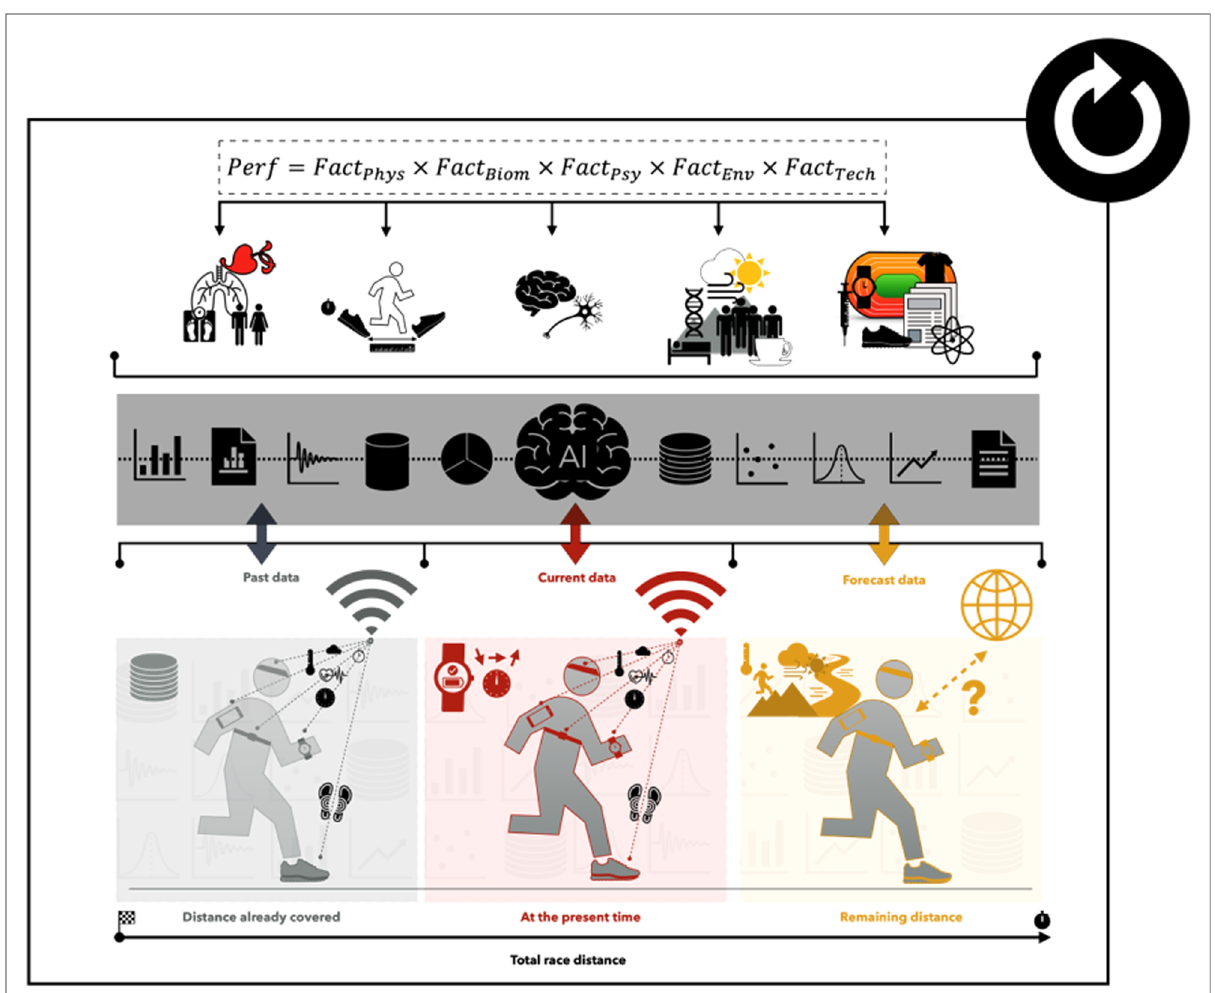
FIGURE 1 Illustration of a “ connected multifactorial ” intelligent model capable of adapting in “ real ” time during the effort to optimize running performance. Fact Phys (physiological